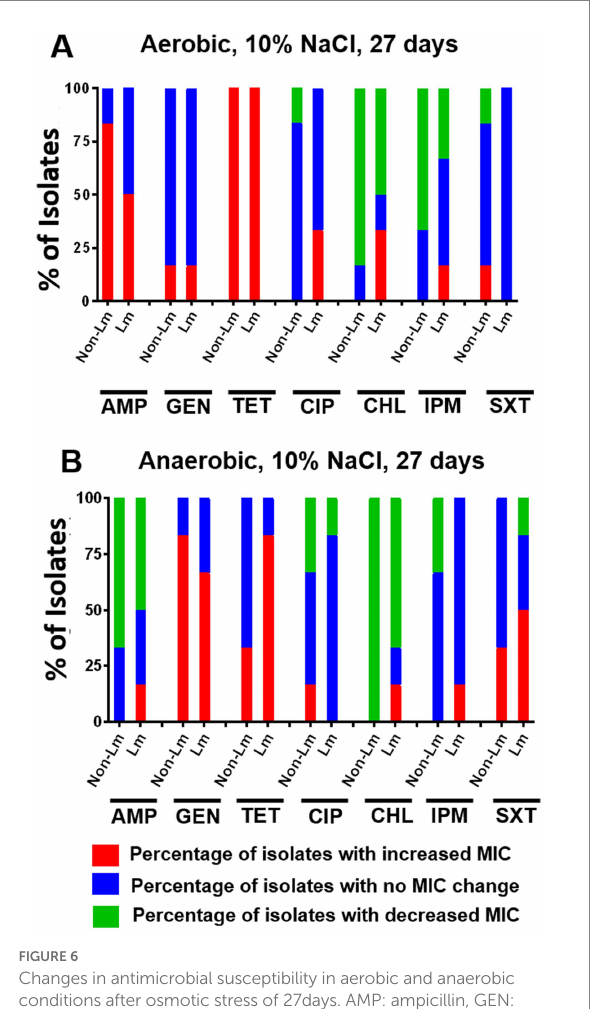
FIGURE 6 Changes in antimicrobial susceptibility in aerobic and anaerobic conditions after osmotic stress of 27 days. AMP: ampicillin, GEN: gentamicin, TET: tetracycline, CIP: ciprofloxacin, CHL: chloramphenicol, IPM: imipenem, SXT: trimethoprim- sulfamethoxazole. (A) Change of MIC (increase/decrease) after osmotic stress of 27 days compared with pre-stress (before stress) under aerobic incubation. (B) Change of MIC (increase/decrease) after osmotic stress of 27 days compared with pre-stress (before stress) under anaerobic